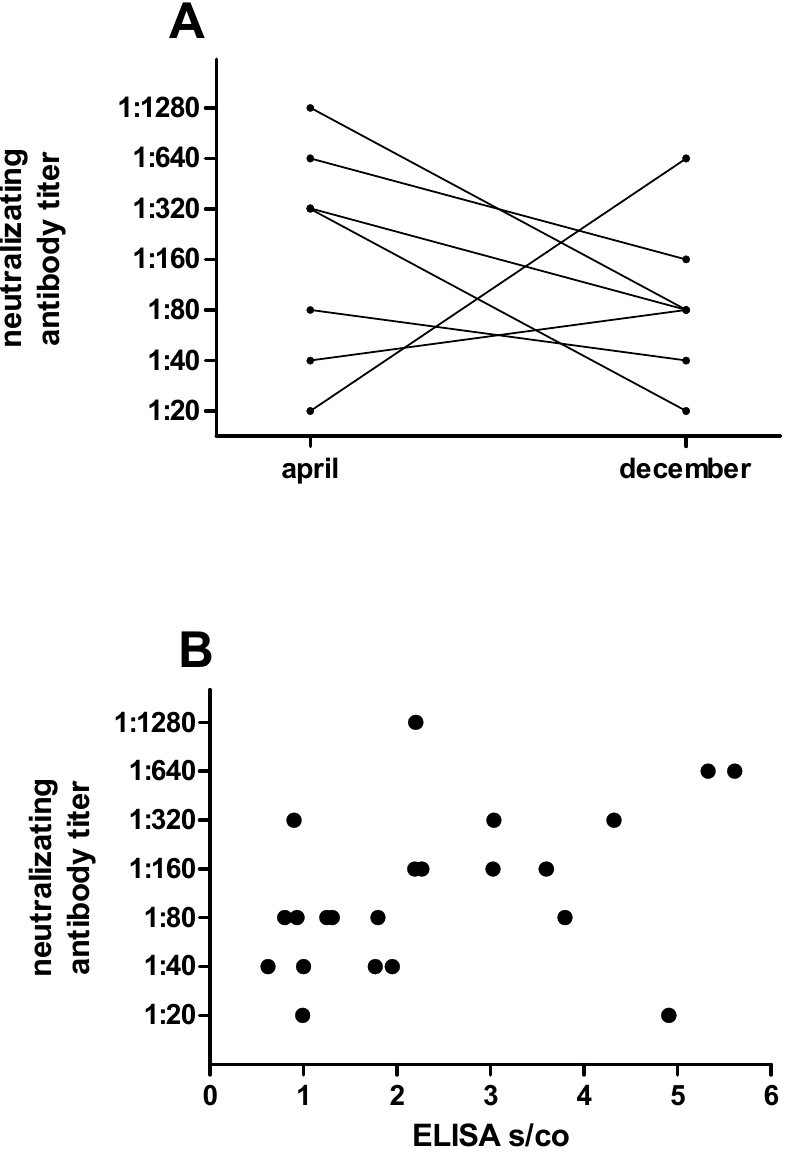
Figure 3. Distribution and follow up of neutralizing antibody titers in healthcare workers. ( A ) Fol- low up of 5 patients with detectable neutralizing antibody titers in April and December 2020. The undetectable SARS-CoV-2 neutralizing antibody titer of two participants are not illustrated. ( B ) Cor- relation of EUROIMMUN SARS-CoV-2 IgG ELISA signal to cutoff (S/CO) ratio and neutralization antibody